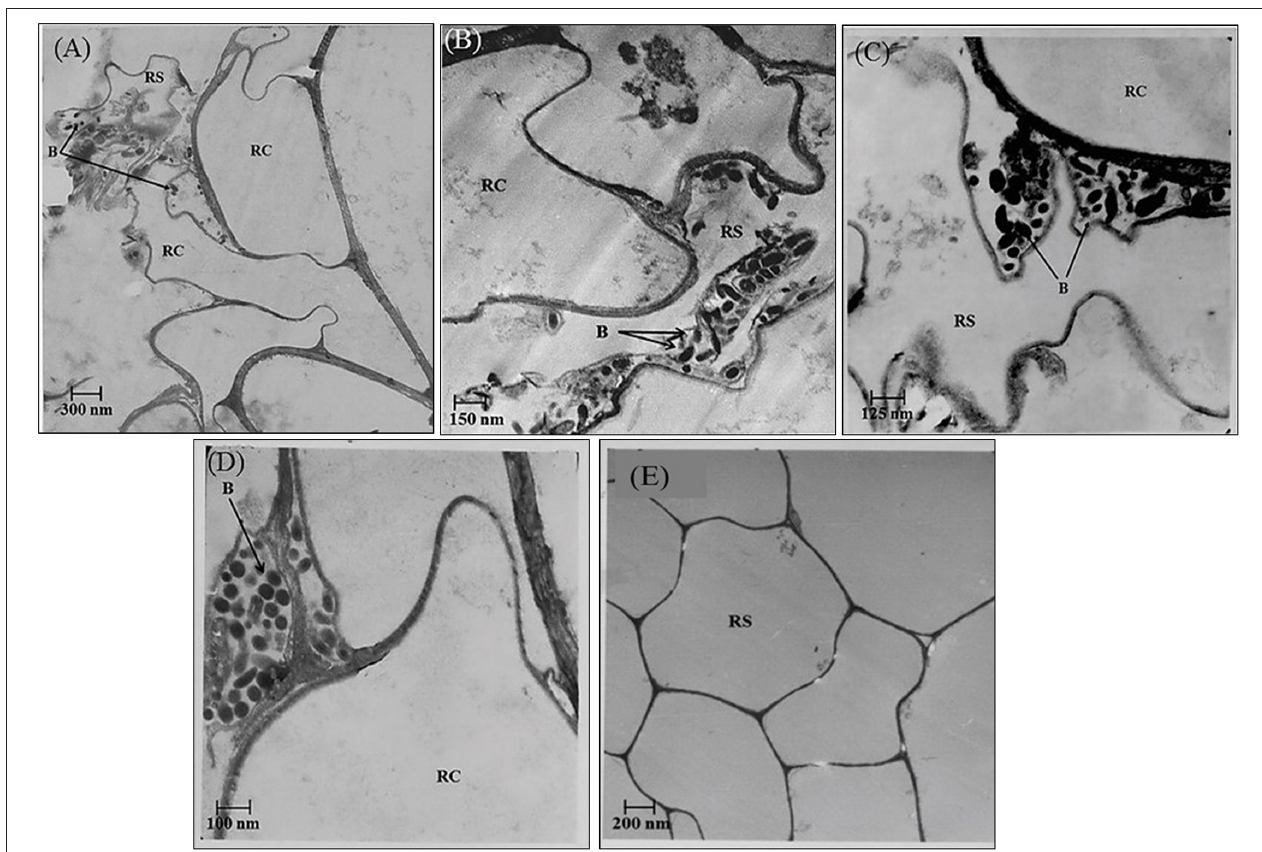
FIGURE 2 | Electron-micrograph of ultrathin sections of root inoculated with Azospirillum sp. TN03 after 30 days. RC = Root cell, B = Bacterium and RS = Rhizosphere. Azospririllum sp. TN03 formed micro-colonies over the root cells surface and in the root hairs grooves (A) . Bacterial cell clusters are present on the root epidermal cells (B–D) forming multiple layers of cell on it and in uninoculated control plants no microbial cells or clusters were observed (E)